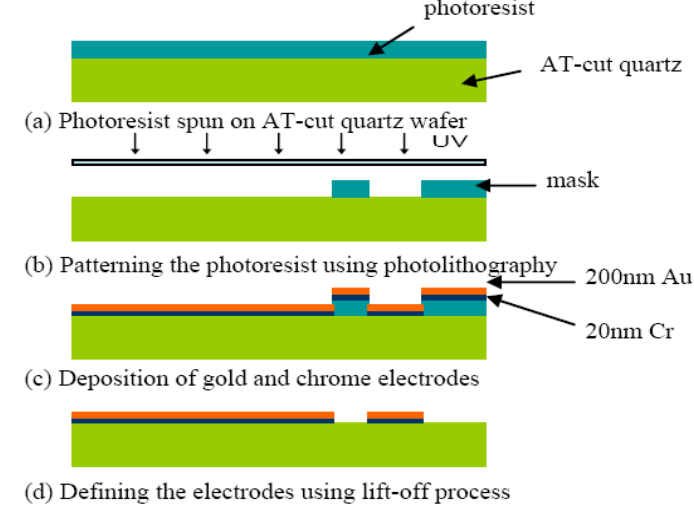
Figure 3. Illustration of the microfabrication process flow of the hybrid biosensor fabricated on an AT-cut quartz